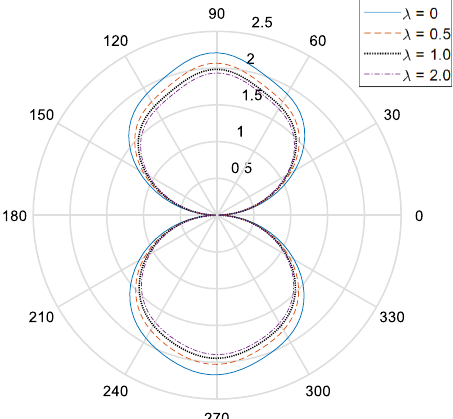
Figure 5. Dynamic stress concentration factor around the upper opening in piezomagnetic composites ( ka = 0.1, d / a = 12.0, λ = (0, 0.5, 1.0, 2.0)).